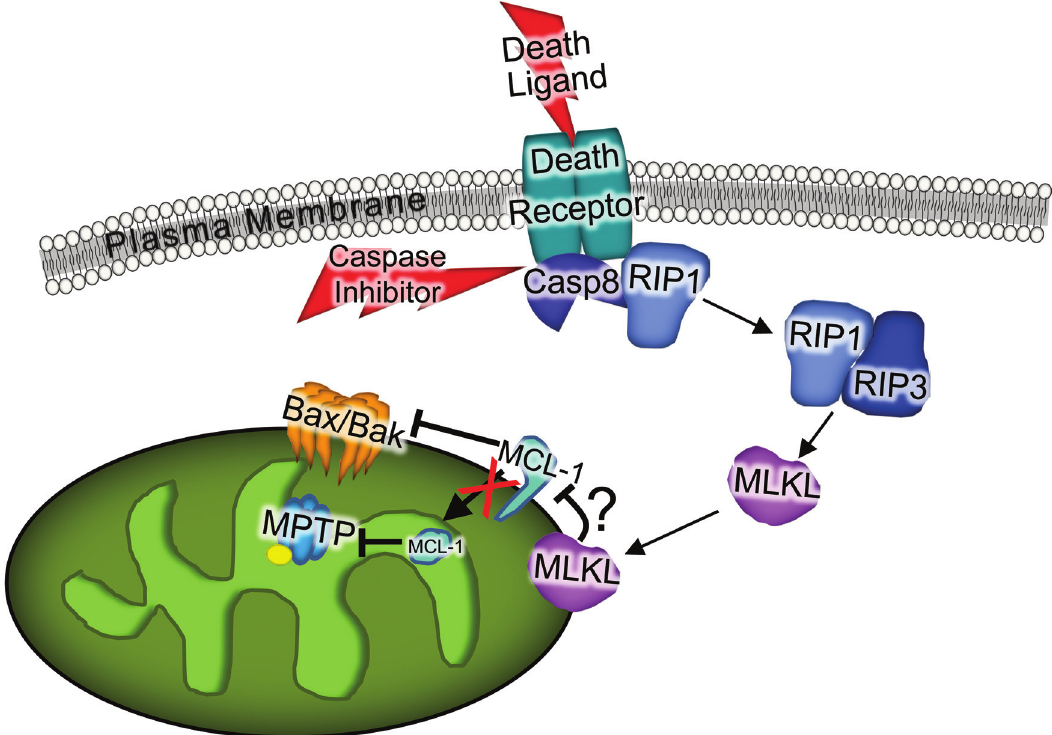
Fig 5. The necroptotic pathway and mitochondrial involvement. Schematic representation of the necroptotic pathway showing that upon treatment of TNF α and zVAD-FMK, upstream effectors RIP1 and RIP3 lead to MLKL translocation to the mitochondria where matrix Mcl-1 is depleted and the MOMP and MPTP are engaged, thus leading to mitochondrial dysfunction that is necessary for effective cell death through